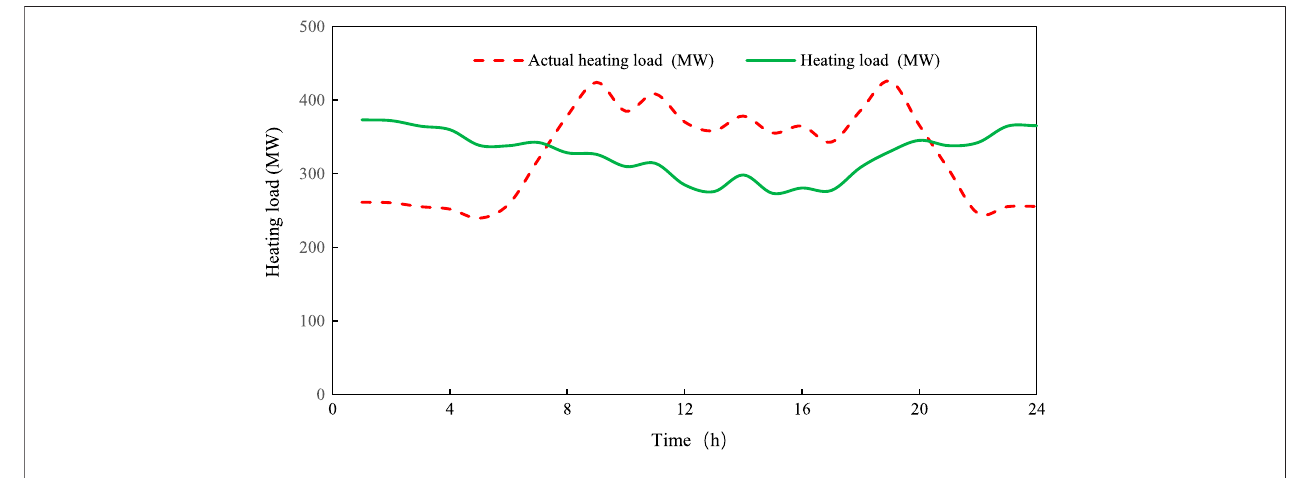
FIGURE 10 | Comparison of heating load and actual heating load in